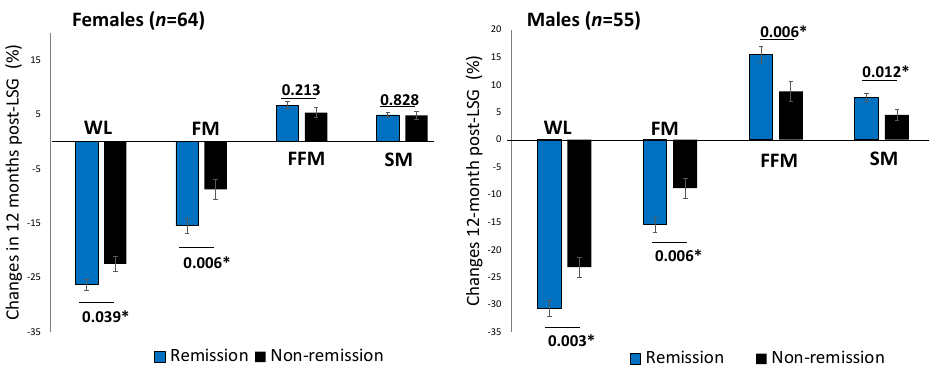
Figure 2. Changes in body composition between T2D remission and non-remission at 12 months post-LSG according to sex difference. Comparison of percent changes of WL, FM loss, FFM, and SM between T2D remission (black bars) and non-remission (grey bars) groups one year after LSG in females ( n = 64) and males ( n = 55). The analysis of covariance test was adjusted for age. * p < 0.05.